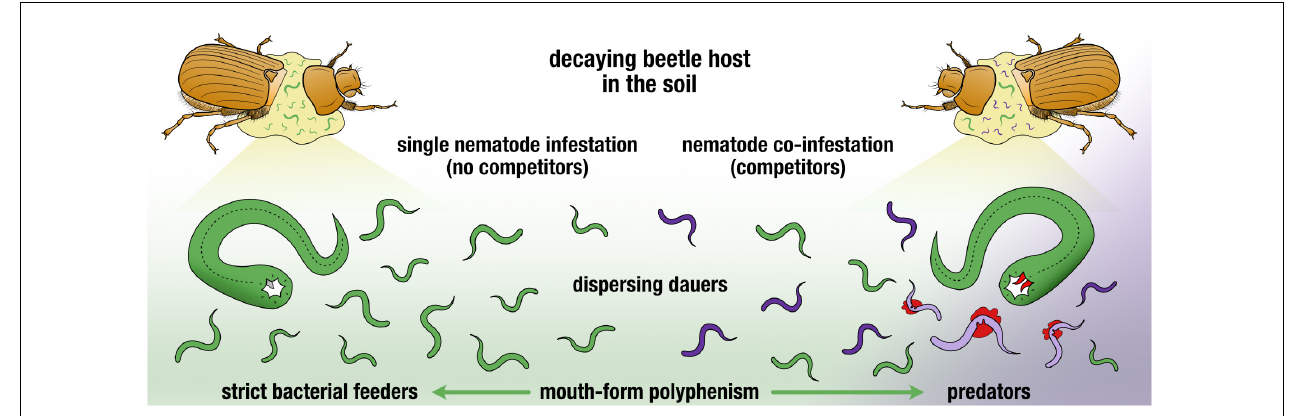
FIGURE 4 | Graphical summary of two nematode plastic responses in face of resource competition post-beetle death. Dauers continuously disperse and P. mayeri develops as predators when co-infesting the host with Acrostichus